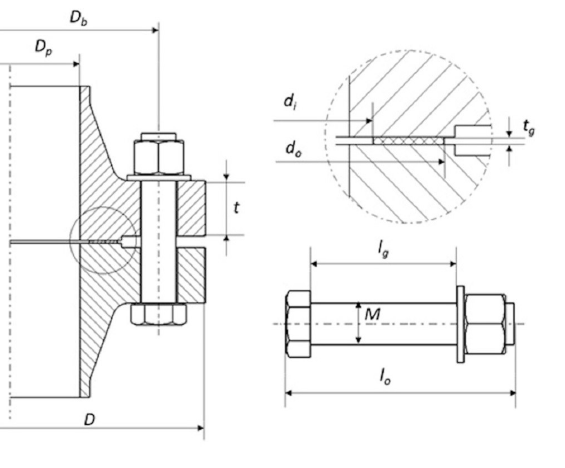
Figure 2: The characteristic dimension of the flange-bolted joint